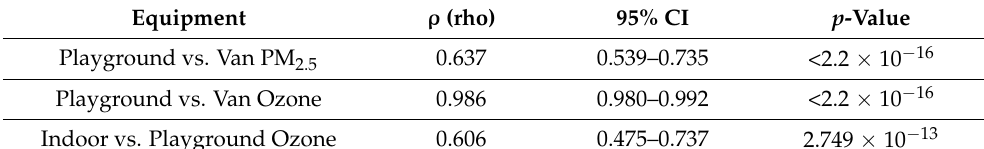
Table 8. Bonneville Phase 2 Spearman correlation test results for site pollutant readings.